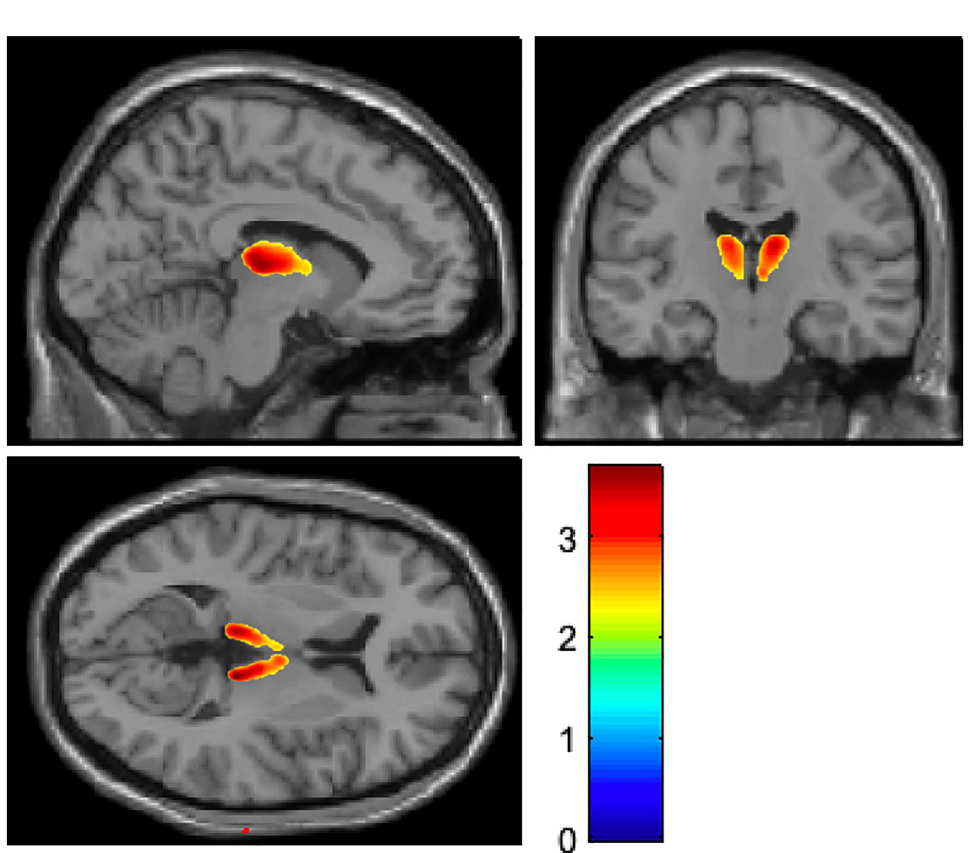
Figure 1. Voxel-based comparison of 18 F-N-(3-fluoropropyl)-2beta-carbon ethoxy-3beta-(4-iodophenyl) nortropane positron emission tomography ( 18 F-FP-CIT PET) between patients with drug-induced parkinsonism (DIP) and the healthy control group. Differences in standardized uptake value ratios (SUVRs) between the two groups (T values of Statistical Parametric Mapping) are visible in the colored region. High T value (red color) indicates that a large differences exists between two groups. The colored region showed a significant area of p -value set as 0.01. The SUVR values in the thalamus of patients with DIP were lower than those of healthy